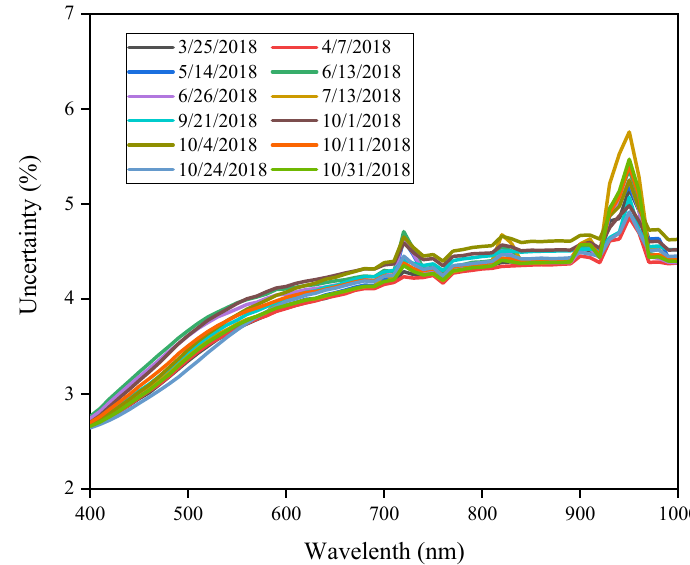
Figure 15. Overall uncertainty results of the TOA radiance covering 400 nm to 1000 nm on the study dates. Table 6. Overall uncertainty of the TOA reflectance in bands 2, 3, 4, and 8 of Sentinel-2B/MSI.